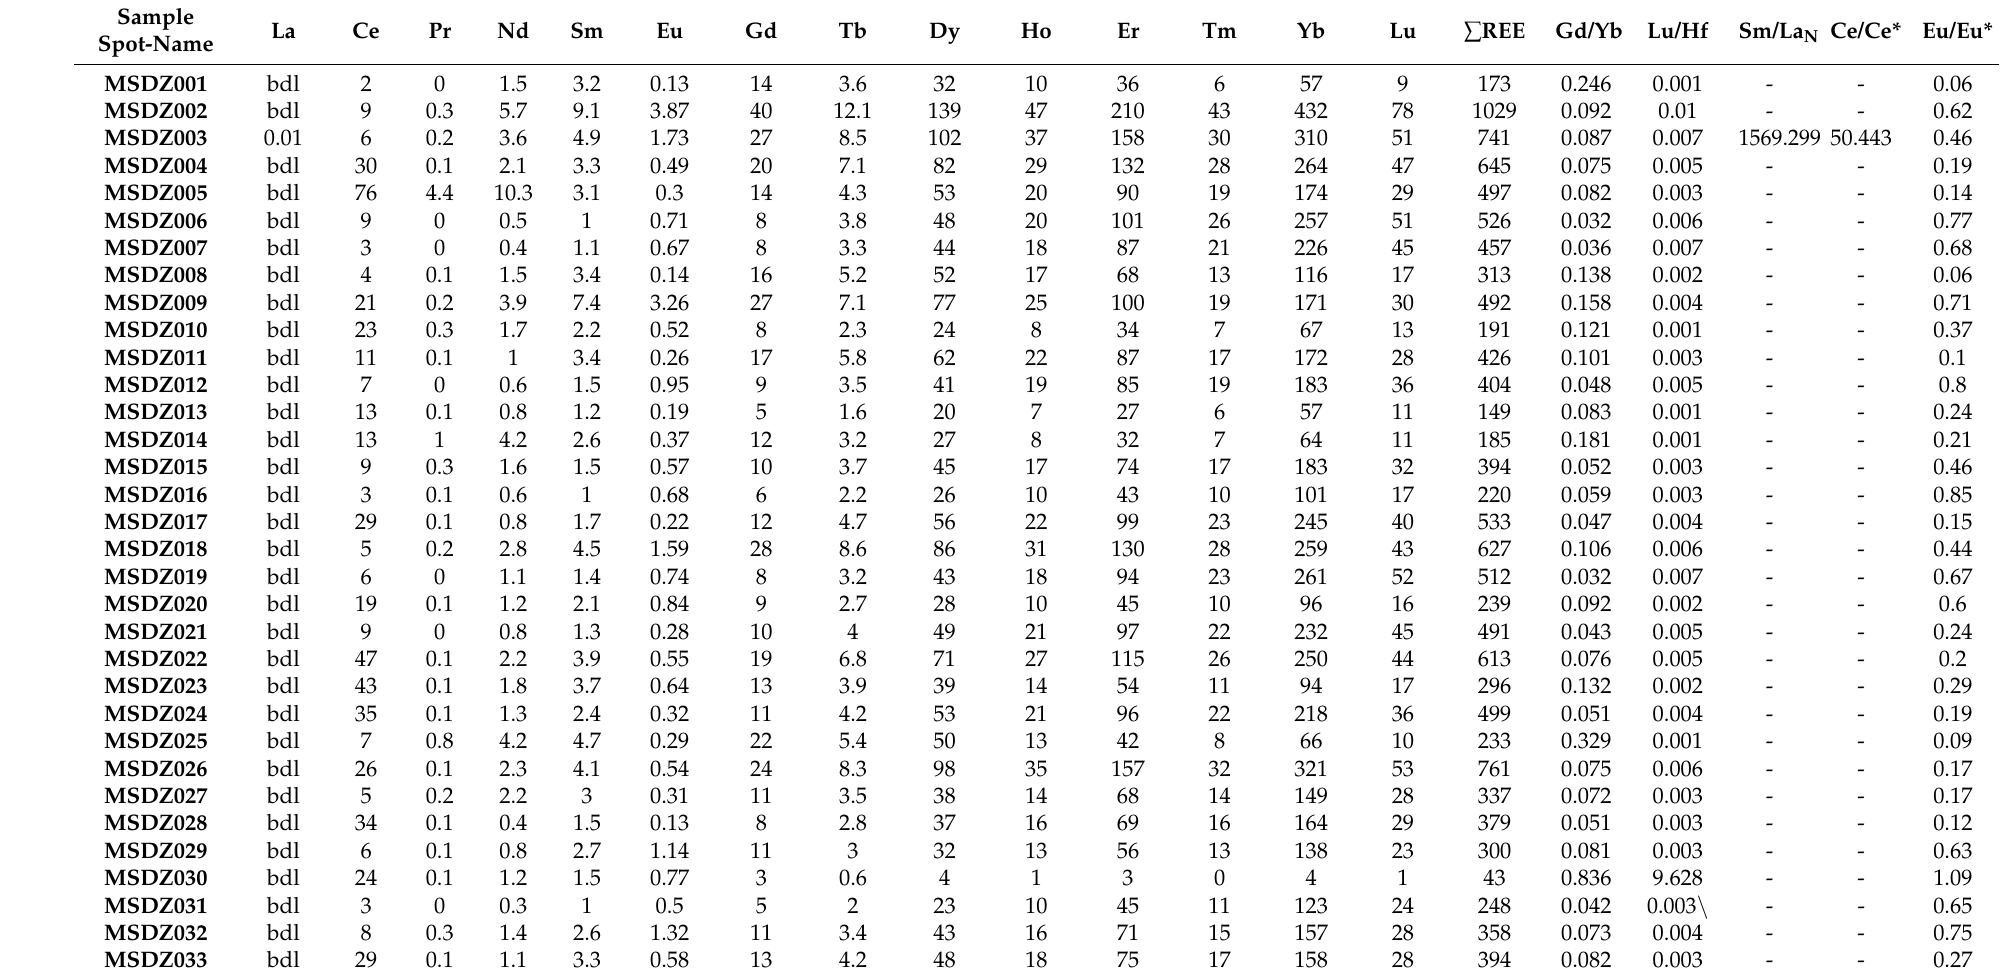
Table 4. Rare earth element abundance (in ppm) in the southern Meiganga detrital zircons. REE (rare earth